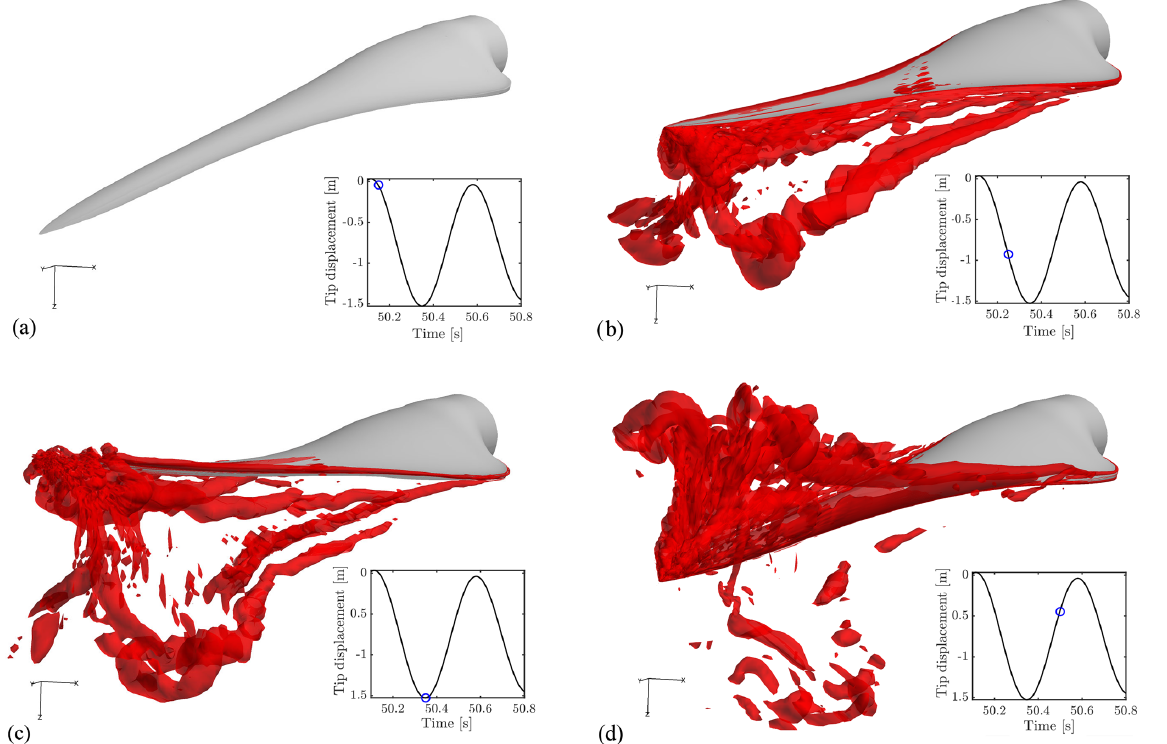
Figure 7. Isobars of the Q criterion during oscillation in the confined configuration. Q crit = 500. Graphs show the position of the blade tip for each figure.